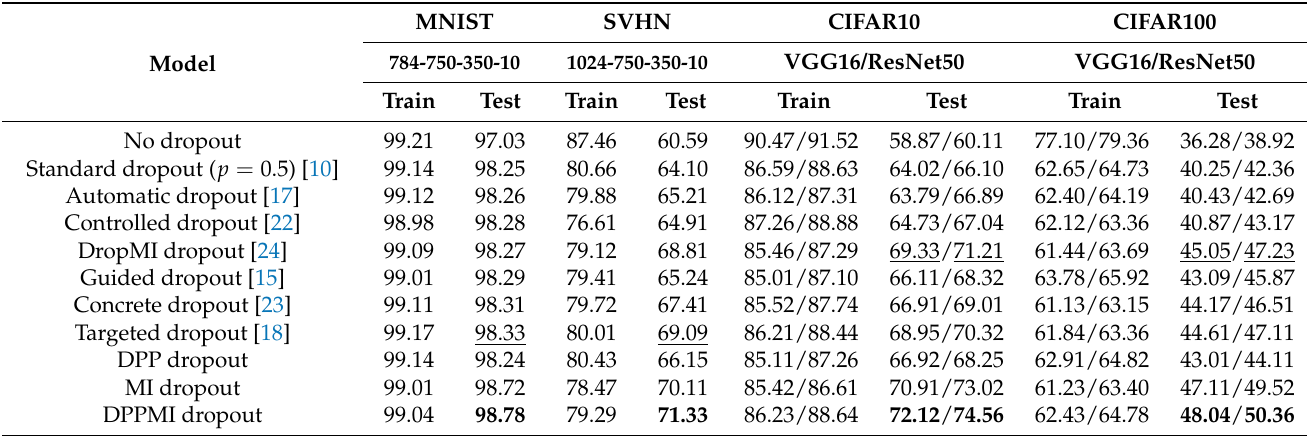
Table 1. Classification accuracies (%) on the digit recognition (MNIST and SVHN) and object recognition (CIFAR10 and CIFAR100) tasks. Please note that the best test results are marked in bold fonts and the best results among the underlying baselines are marked by underline,